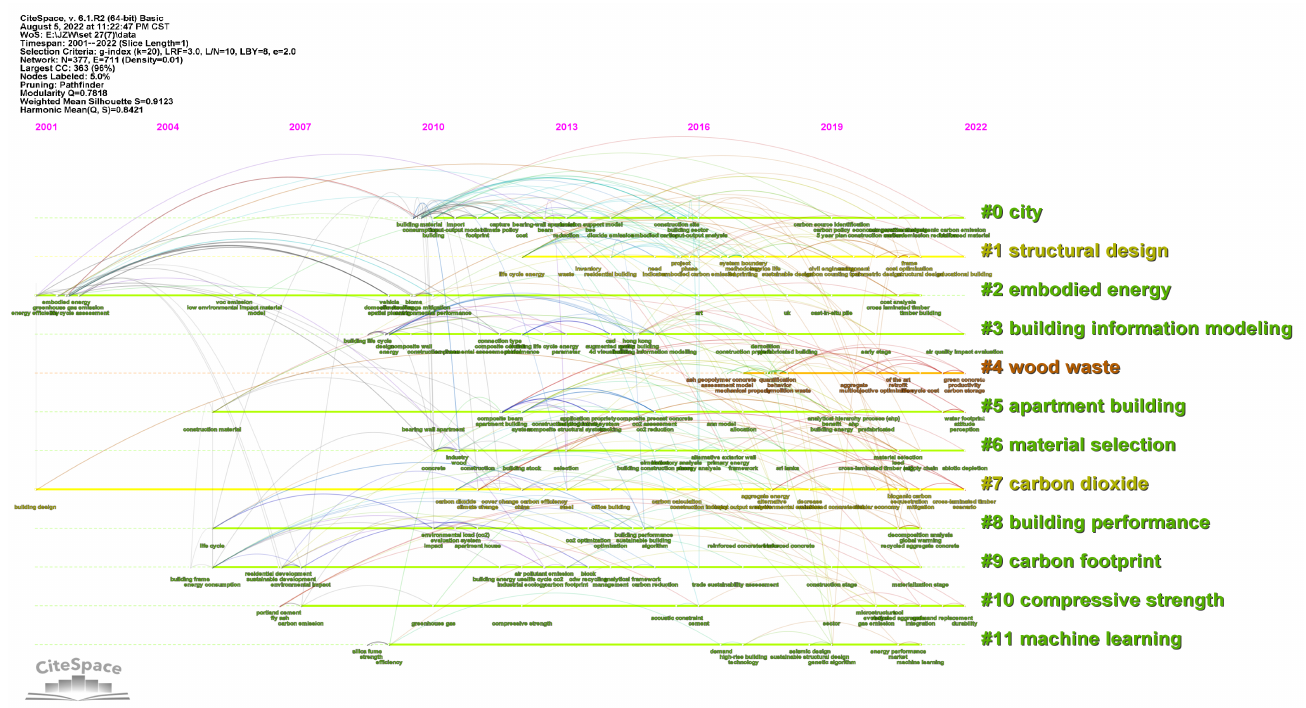
Figure 5. A timeline view of keyword co-occurrence in